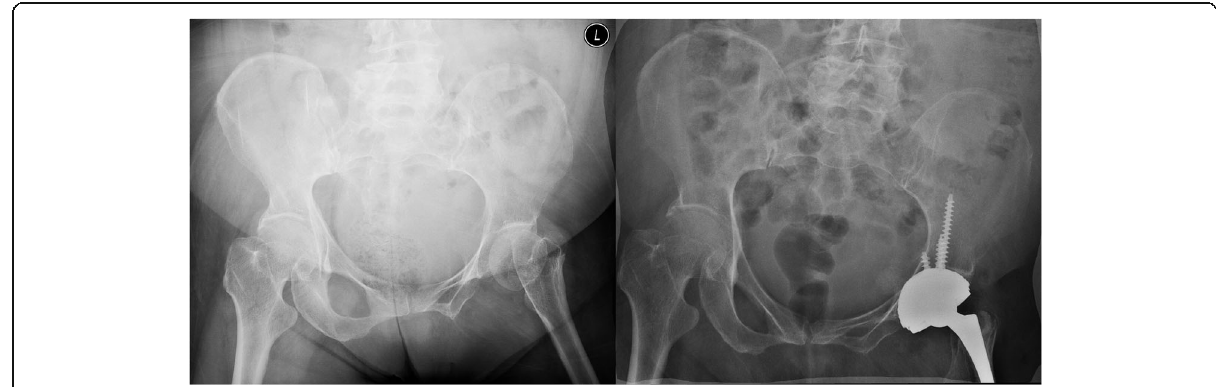
Fig. 3 Case No. 7 in Table 1. a The left hip had a fractured neck of femur with abductor deficiency due to poliomyelitis. b DM total hip arthroplasty on the left